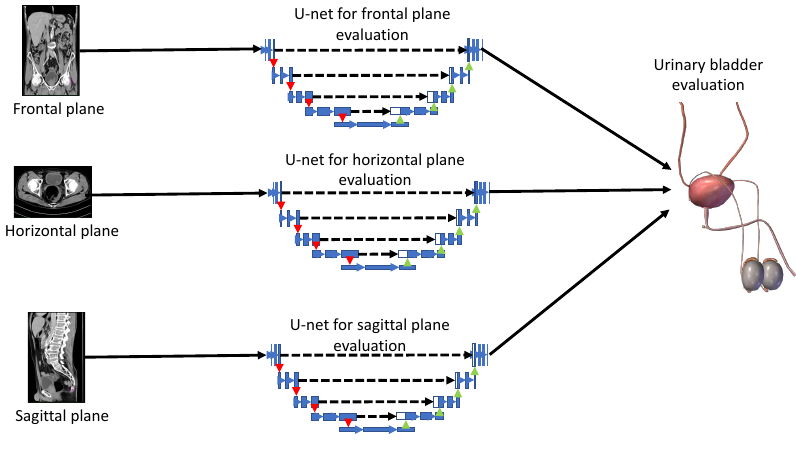
Figure 5. A block scheme of the proposed parallel U-net